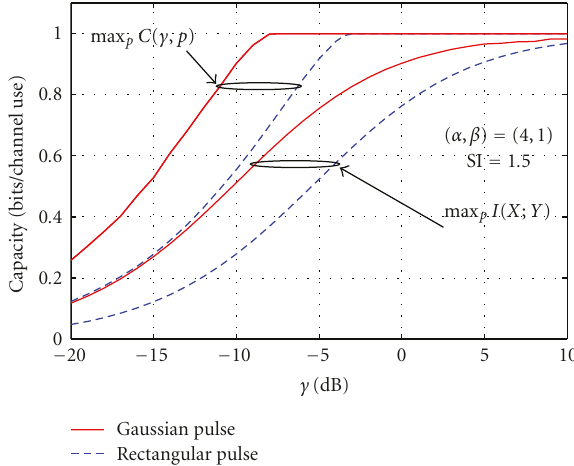
Figure 5: Maximization of the capacity bound in (11) and mutual information over the input distribution p for the atmospheric turbulent optical channel when κ = 20 and a scintillation index of SI = 1 . 5 are adopted with rectangular and Gaussian pulse